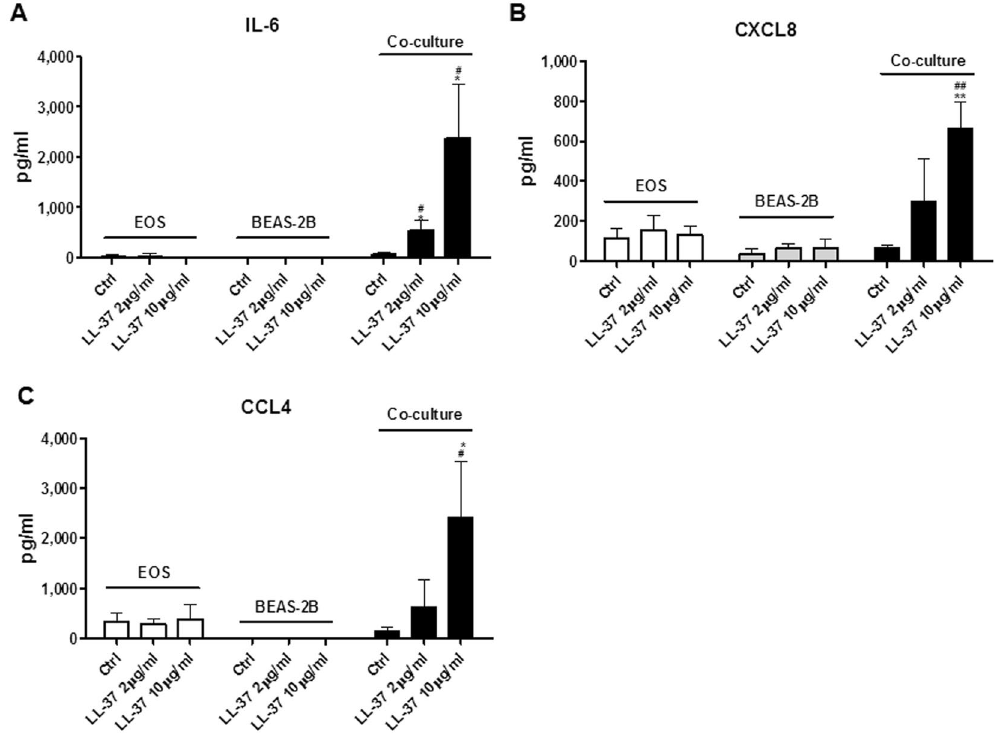
Figure 2. Effects of LL-37 on the induction of cytokines/chemokines upon co-culture of eosinophils and BEAS-2B cells. Human eosinophils (3 × 10 5 ) and BEAS-2B cells (1 × 10 5 ) were cultured either together or separately with or without 10 μ g/ml LL-37 for 20 h. Release of IL-6 ( A ), CXCL8 ( B ) and CCL4 ( C ) in culture supernatant was determined. EOS, eosinophils. Results are shown as arithmetic mean plus SD of triplicate independent experiments. * P < 0.05, ** P < 0.01 when compared between denoted groups and eosinophil control groups. # P < 0.05 , ## P < 0.01 when compared between denoted groups and co-culture control